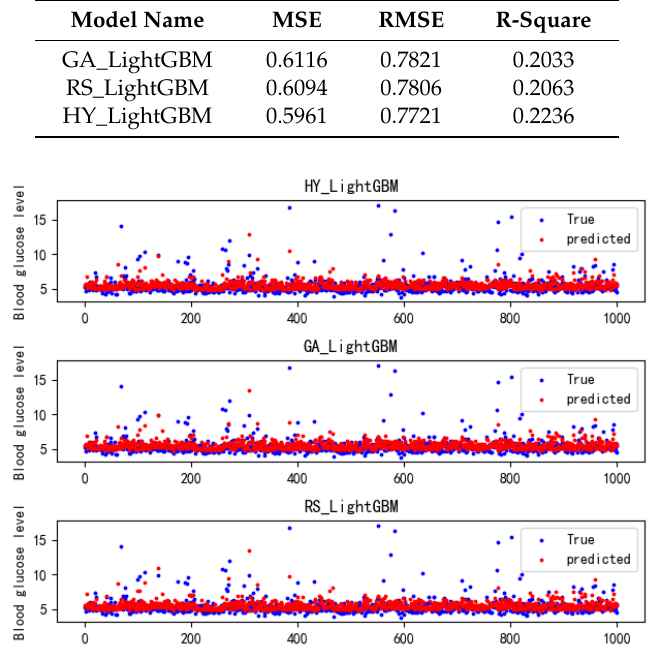
Figure 13. Comparison chart of the predicted performance of HY_LightGBM, GA_LightGBM, and